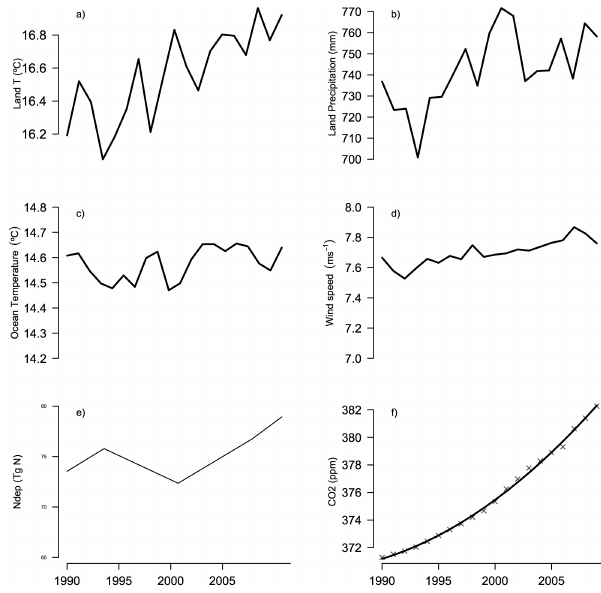
Figure 2. Global trends in environmental driving variables: (a) land temperature, (b) land precipitation, (c) ocean temperature, (d) wind speed, (e) N deposition, and (f) atmospheric [CO 2